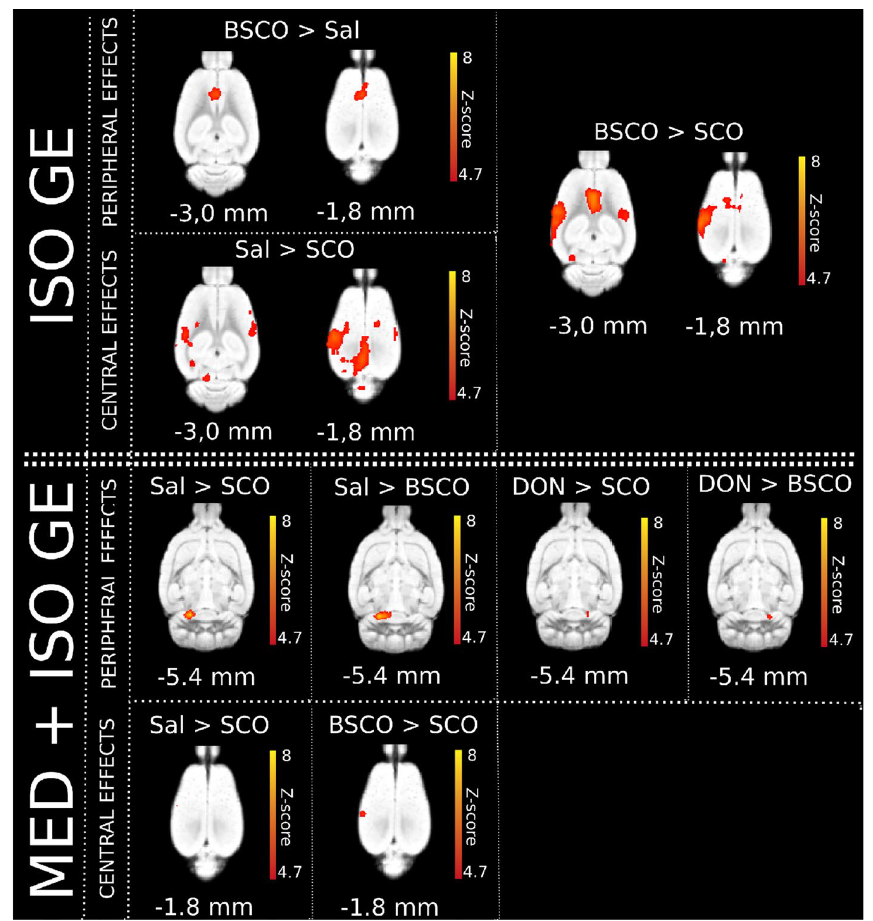
Figure 4. Summary figure of the whisker-stimulated evoked BOLD response differences between pretreatment groups with GE EPI sequences in both anesthesia types (isoflurane—top: ISO GE, (n = 54; 18 per pretreatment group); medetomidine-isoflurane—bottom: MED + ISO GE, n = 62; 15, 16, 16, 15 of Sal, SCO, BSCO, DON, respectively) according to their peripheral/central effects. In ISO anesthesia, in the BSCO > Sal contrast a peripheral effect, in the Sal > SCO contrast probable central effects are seen. In the BSCO > SCO contrast both effects are seen. In the combined anesthesia (MED + ISO GE) we found probable peripheral effects at the (right or left) inferior colliculus/transverse sinuses in the Sal > SCO, Sal > BSCO, DON > SCO and DON > BSCO contrasts. The central effects (in the left barrel field) are shown in the BSCO > SCO and Sal > SCO group differences. The Z-scores represent the probabilistic TFCE (pTFCE) statistics (p < 0.05 correcting for multiple comparisons via GRF theory based FWER, red-to-yellow z = 4.7 to z = 8). The corresponding colorbars are depicted next to every group difference on the right. The z coordinates (distance from Bregma) of the selected slices (− 5.4 mm; − 3.0 mm; − 1.8 mm) are given at the bottom of the